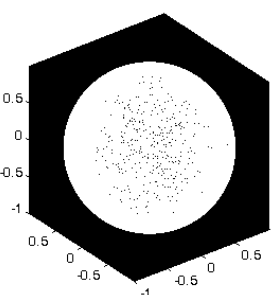
Figure 4. 3-Dimensional of the star catalogue